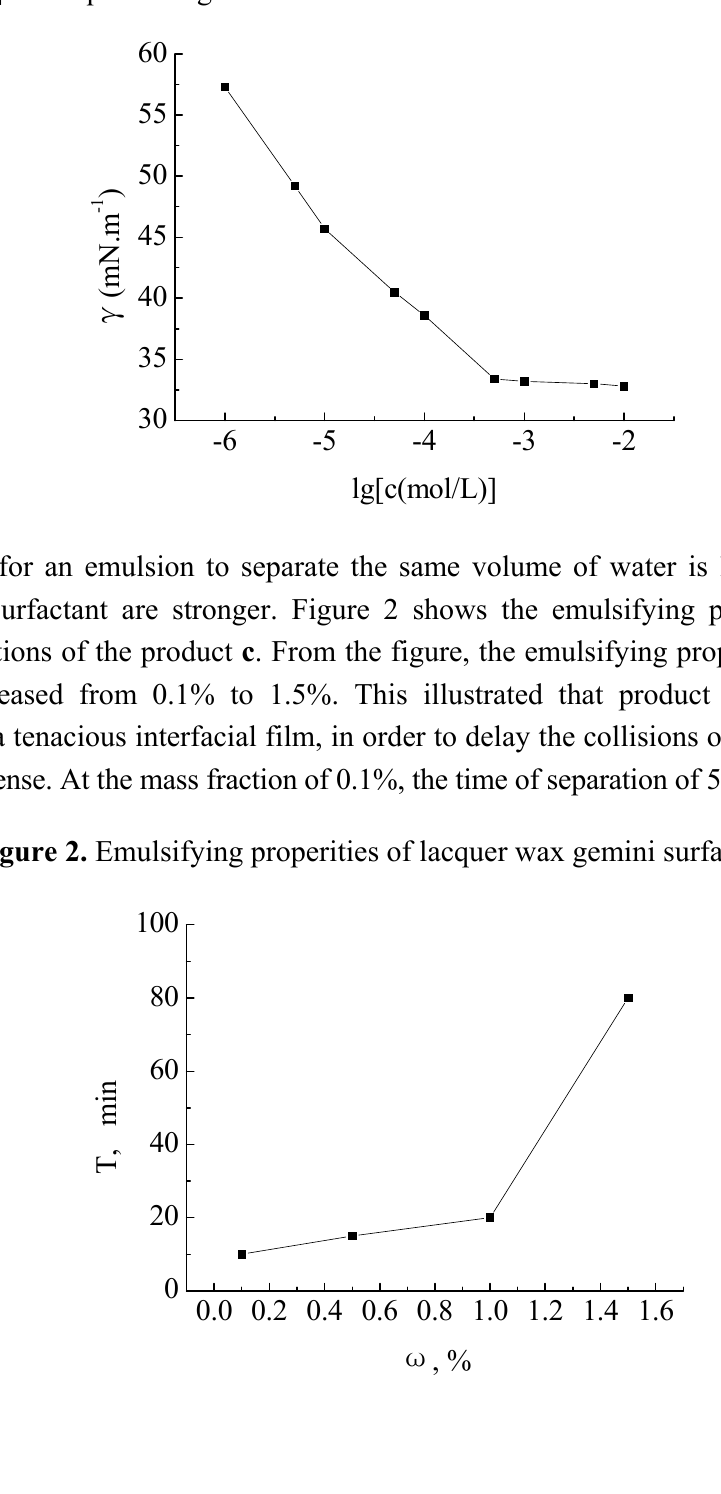
Figure 1. Surface tension ( γ ) (mN·m − 1 ) versus logarithm of aqueous molar concentration